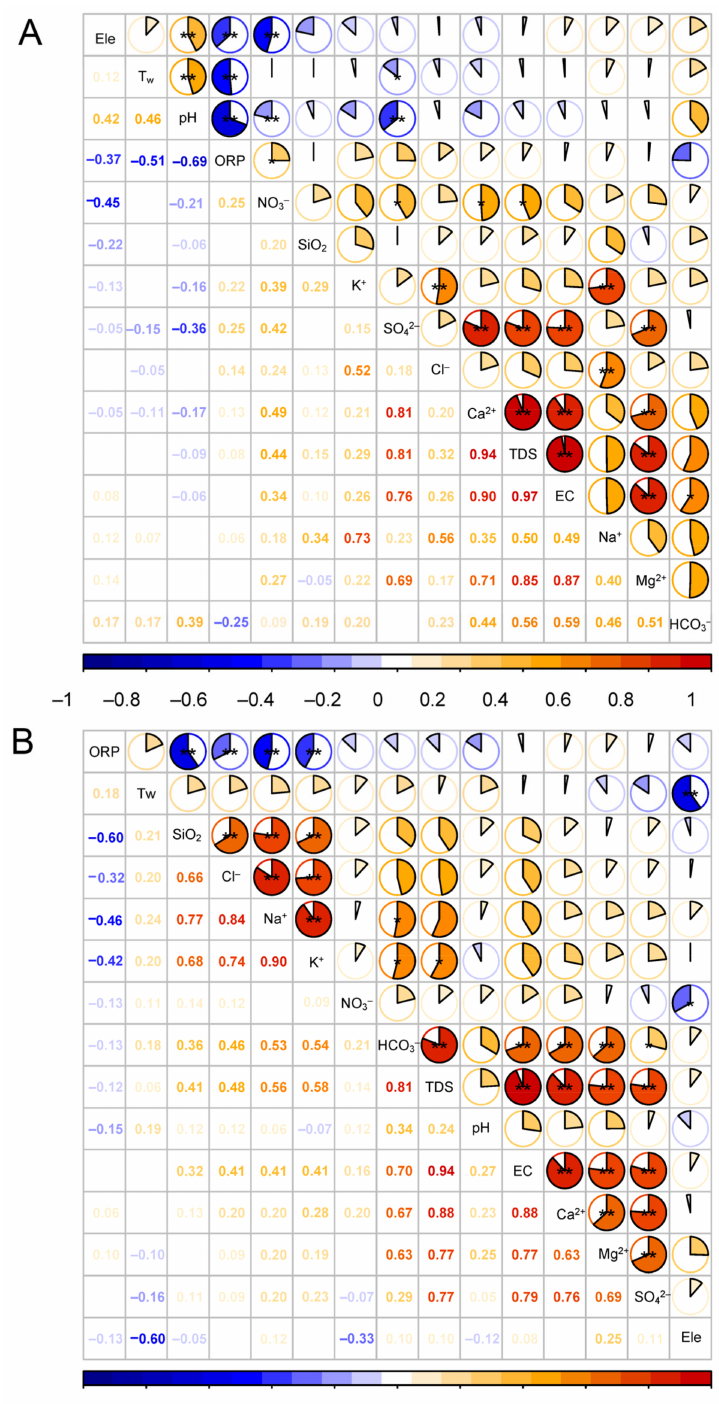
Figure 7. Heatmap of correlation coefficients among different hydrochemistry parameters in the rainy season ( A ) and the dry season ( B ). The pie charts area indicates the strength of the correlation. Blue and red colors mean positive and negative correlation coefficients, respectively. Meanwhile, * and ** mean significant levels with p < 0.05 and p < 0.01,